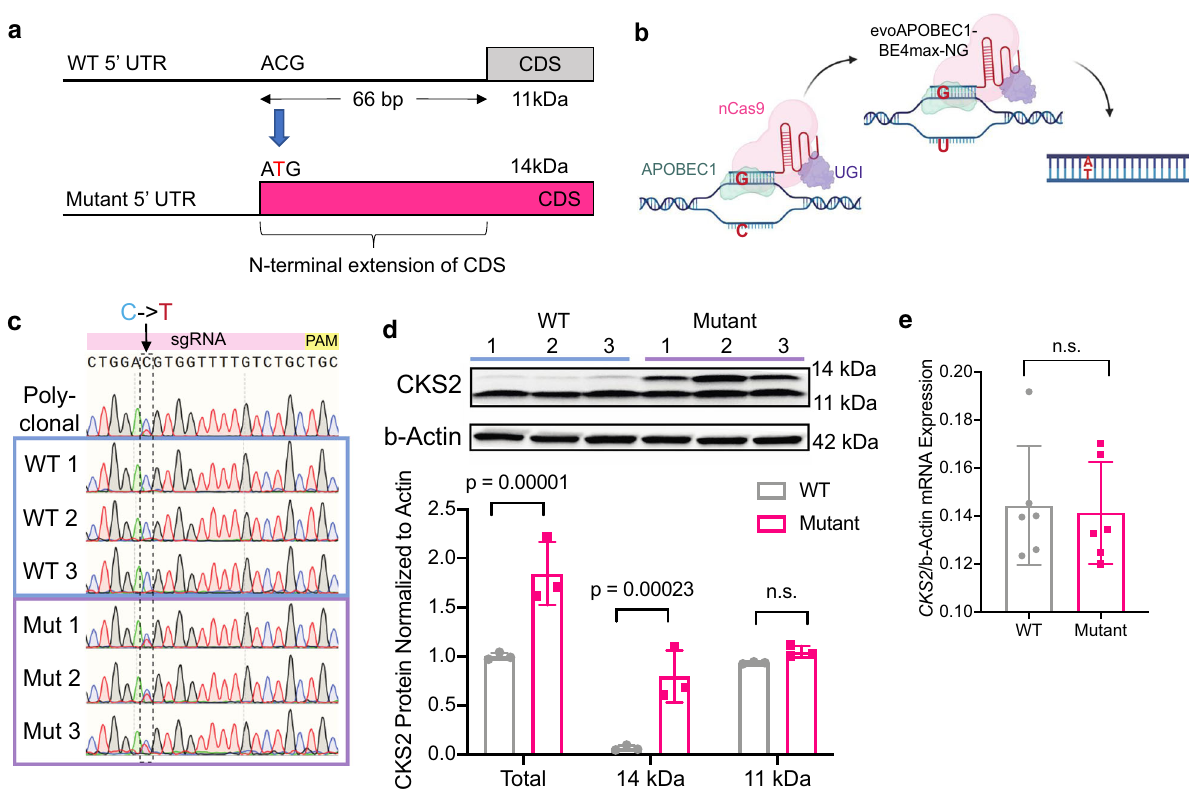
Mutant0.100.120.140.160.180.20 Fig. 6 CRISPR-Cas9 base editing of a point mutation in the CKS2 5 ′ -UTR increased translation ef fi ciency in its endogenous context. a Schematic showing wild-type (WT, top) and mutant (bottom) versions of CKS2 transcript, including 5 ′ -UTR, normal coding sequence (CDS), and mutant N terminally extended CDS. The C to T mutation (chr9: 91926143) within the 5 ′ -UTR of CKS2 generates a start codon that extends the coding sequence of CKS2 . The mutated nucleotide is represented in red. b Method of CRISPR-Cas9 base editing using evoAPOBEC1-BE4max-NG, which is composed of APOBEC1, a Cas9- nickase domain, and uracil-DNA glycosylase inhibitor (UGI). This base editor deaminates target cytosines to uracil, which changes the original G – C base pair into an A – T base pair after DNA repair. c Sanger sequencing traces from polyclonal population of CRISPR-transfected 293T cells and six individual single-cell clones selected from this pool for further study. The target C (blue) ->T (red) mutation in the 5 ′ -UTR of CKS2 is shown within the dashed box. d Western blot of the three WT and three CKS2 mutant clonal cell lines created by CRISPR base editing with antibodies against CKS2 and β -actin. The graph shows these results quanti fi ed using ImageJ, where each CKS2 band intensity was measured and normalized to the intensity of the corresponding β -actin loading control. Statistics show two-sided Student ’ s t test with multiple comparisons correction using the three WT (gray) vs three CKS2 mutant (pink) biological replicates (total p value = 0.00001 and 14kDa p value = 0.00023). Data are presented as mean values ± s.d. Full immunoblots are provided in the Source data fi le. e CKS2 qPCR shows no change in mRNA levels between three WT (represented in gray) and three mutant (represented in pink) clonal cell lines created from CRISPR base editing. CKS2 mRNA levels in each sample were normalized to β -actin as a loading control ( n = 6 biological replicates). Two-sided Student ’ s t test, data are presented as mean values ± s.e.m. n.s. not statistically signi fi cant. Source data are provided as a Source data fi